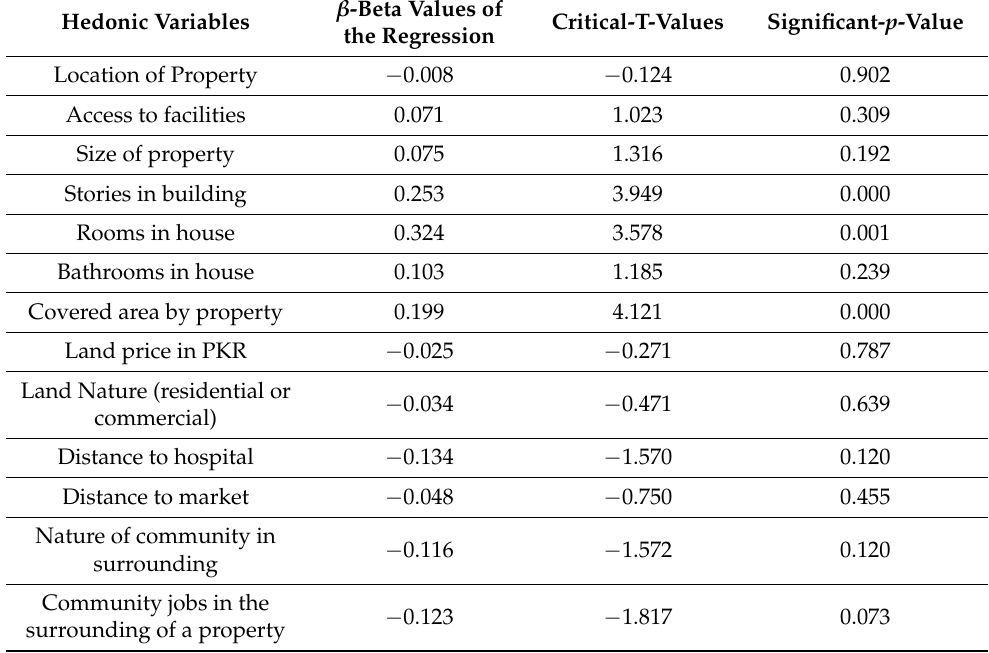
Table 3. Regression coefficients.